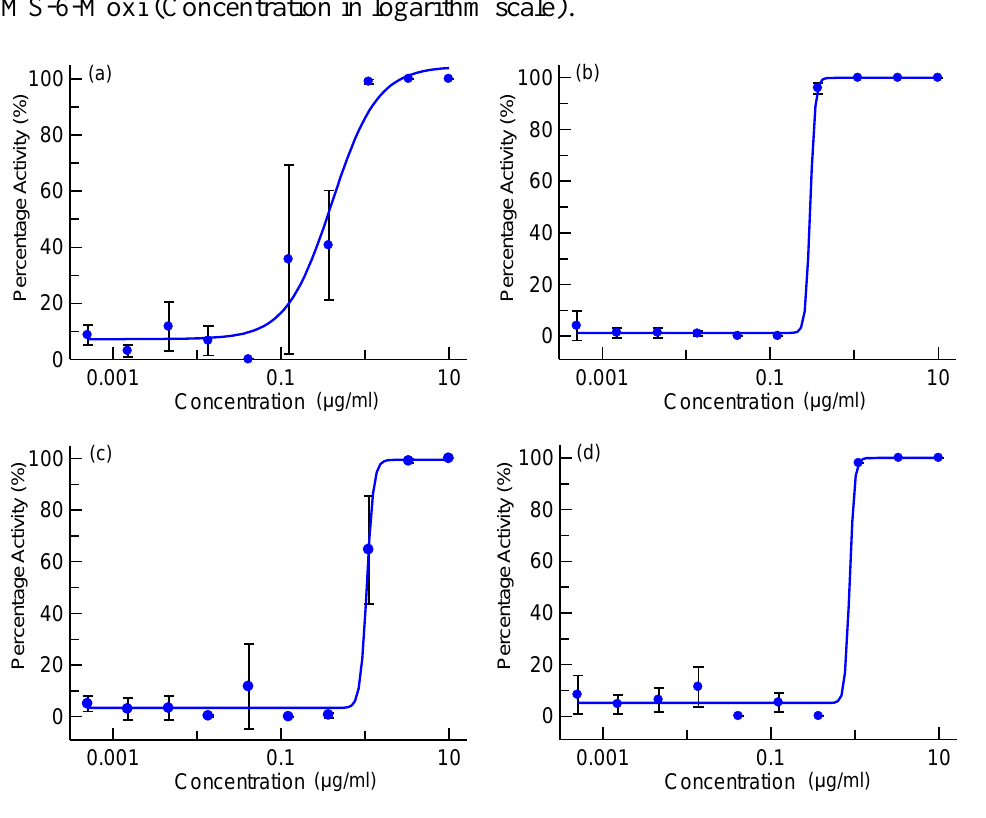
Figure 4. Antibacterial activity percentage of ( a ) PA-824; ( b ) moxifloxacin; ( c ) AMS-6-PA824; and (d) AMS-6-Moxi. Total macrophages number after present them to drugs in different concentrations: ( e ) PA-824; ( f ) moxifloxacin; ( g ) AMS-6-PA824; and ( h ) AMS-6-Moxi (Concentration in logarithm